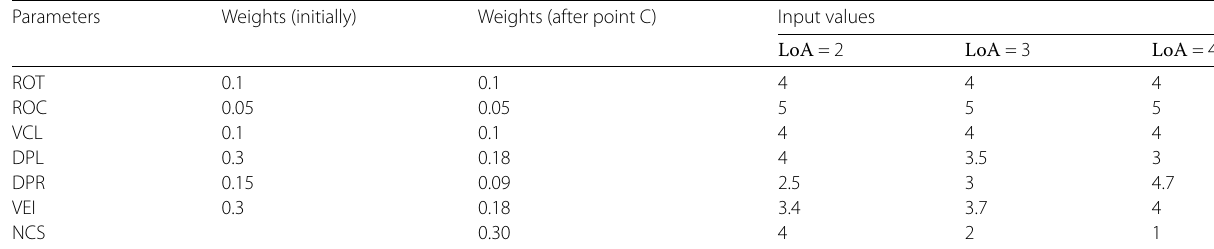
LoA = 2 LoA = 3 LoA = 4